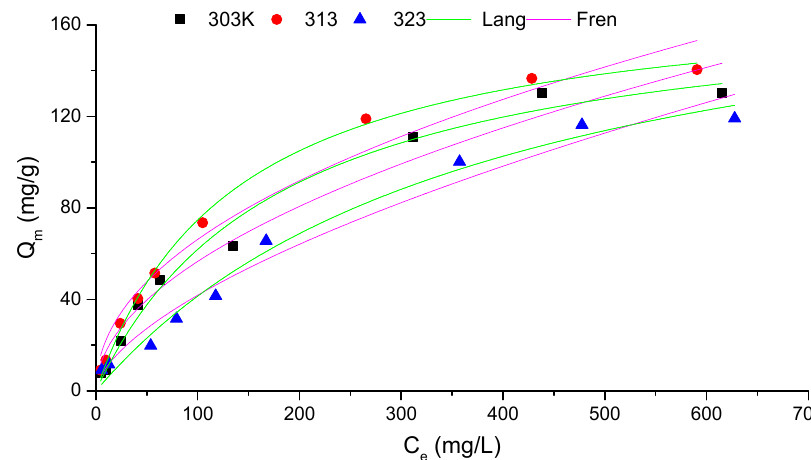
Figure 7. Adsorption isotherms of MG on AP from aqueous solution. Table 3. Model parameters for the adsorption of MG on AP from aqueous solution.